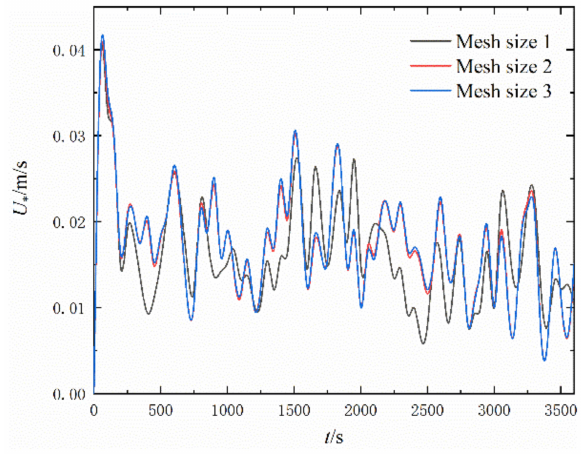
Figure 4. Comparison of near-bed shear velocity U * with different mesh grid size.